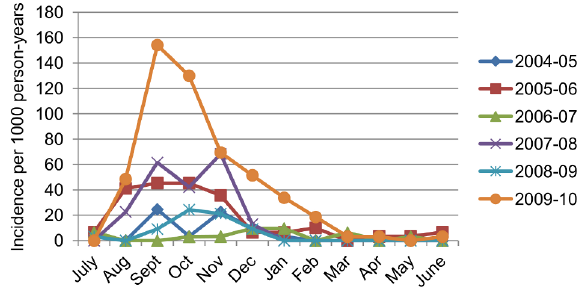
Figure 3. Incidence of dengue cases in the cohort by study year and month, August, 2004–June, 2010. The number of dengue cases by month from 2004–2005 to 2007–2008 has been previously reported